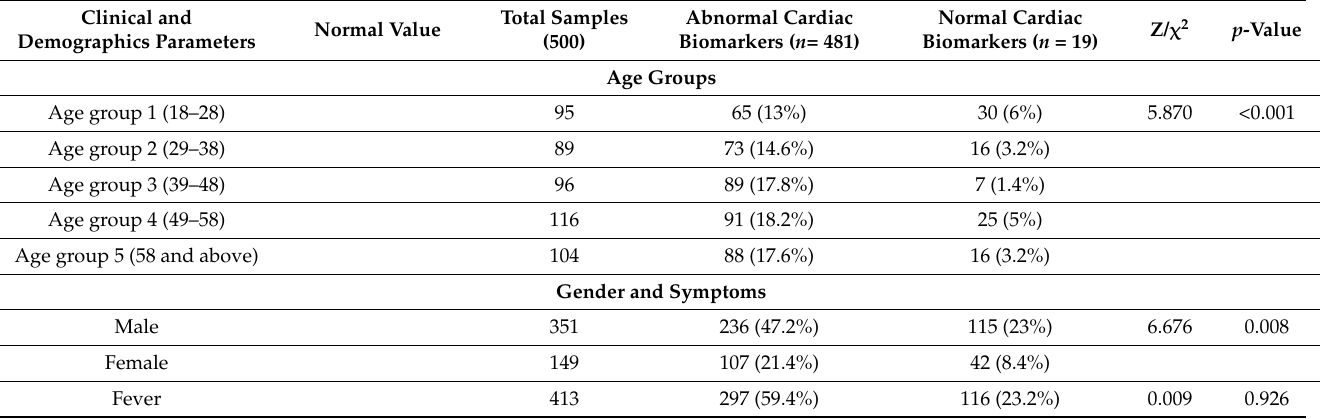
Table 2. Clinical, Demographic and Laboratory Parameter of COVID-19 admitted